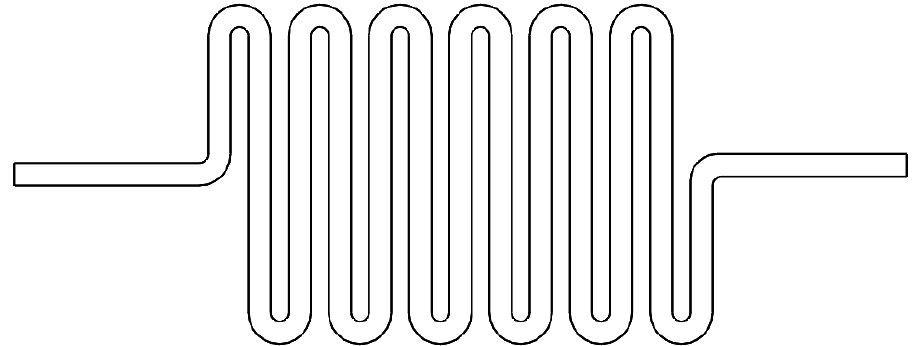
Figure A9. Fabric Design SP-3. Single pass design, woven conductive polyester fabric.